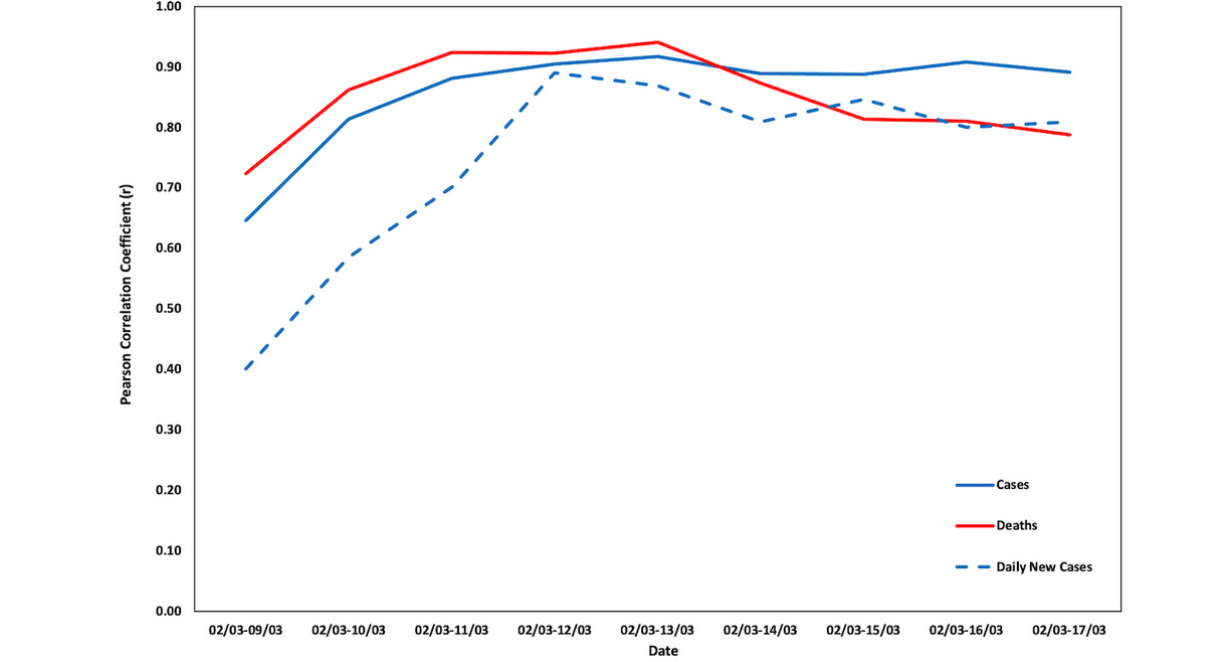
Figure 9. Changes in the Pearson correlation coefficients ( r ) for the United